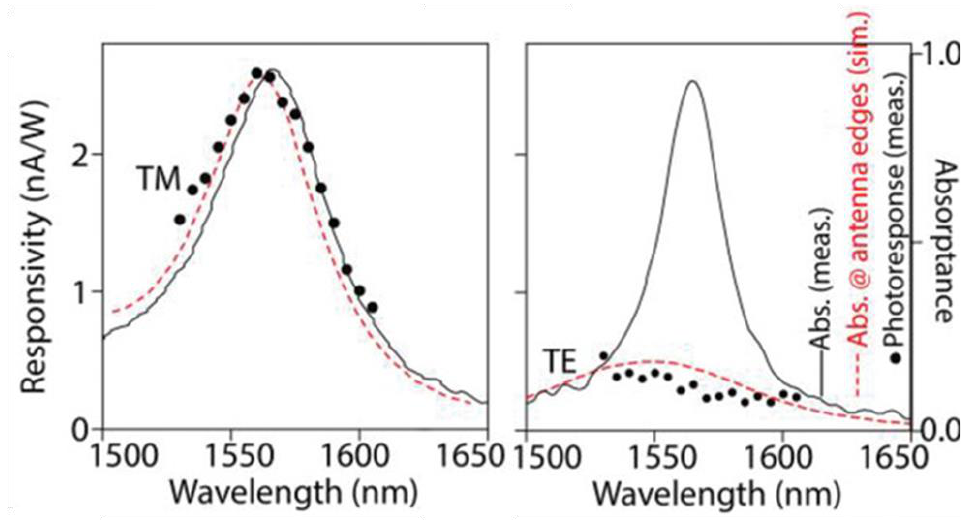
Figure 15. Responsivity spectra of the photodetector for TM and TE-polarized incident light [84]. Copyright 2021 John Wiley & Sons, Inc.